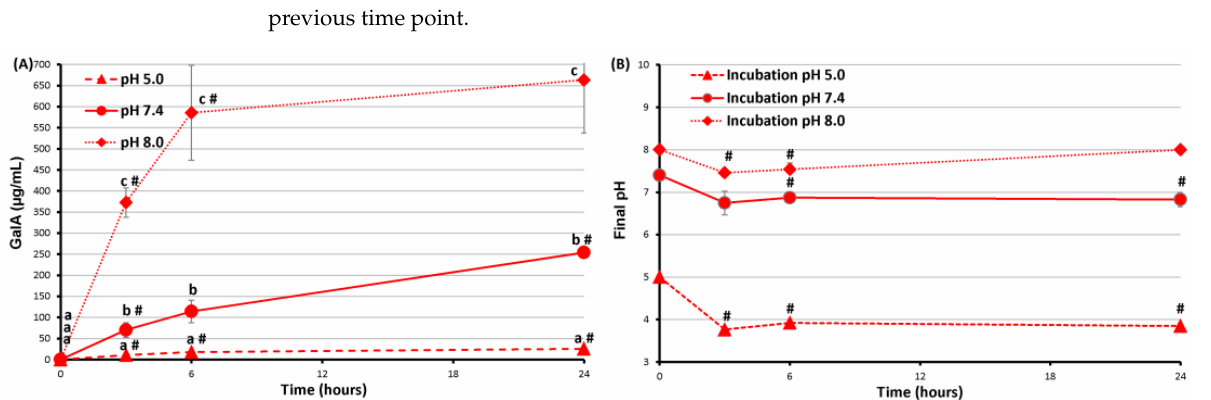
Figure 8. The content of GalA ( A ) and pH ( B ) of the incubation medium during incubation of the FeP hydrogel in Hanks’ solution at a pH of 5.0, 7.4, and 8.0 for 24 h. Different letters — p < 0.05 for different pH conditions; # — p < 0.05 vs. previous time point.